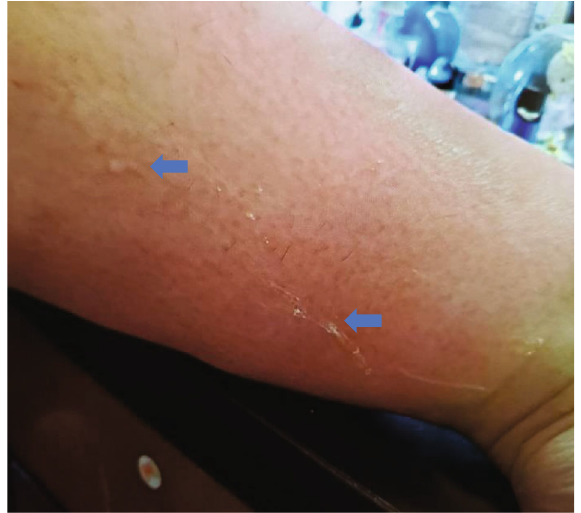
Figure 1: A photograph of the left calf taken by the patient at home. The blue arrows indicate the fl uid seeping from the edema. The white residues are dried fl